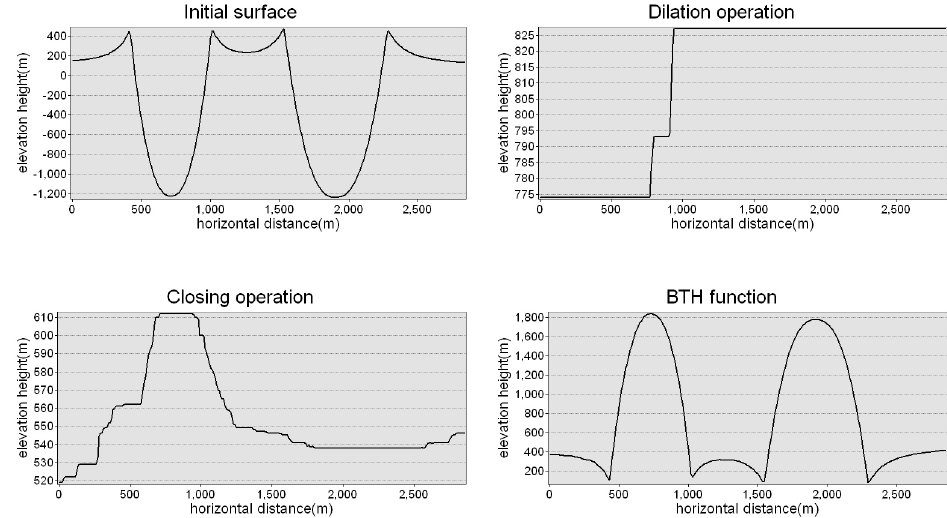
Figure 1. 1D profiles of craters after extraction by the Black Top Hat Transform function (BTH).